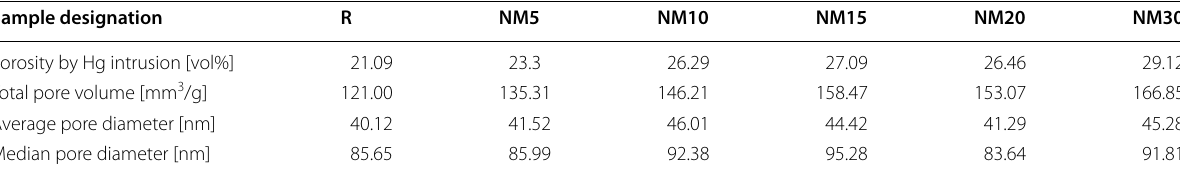
Table 4 Basic parameters of pore structure measured by MIP